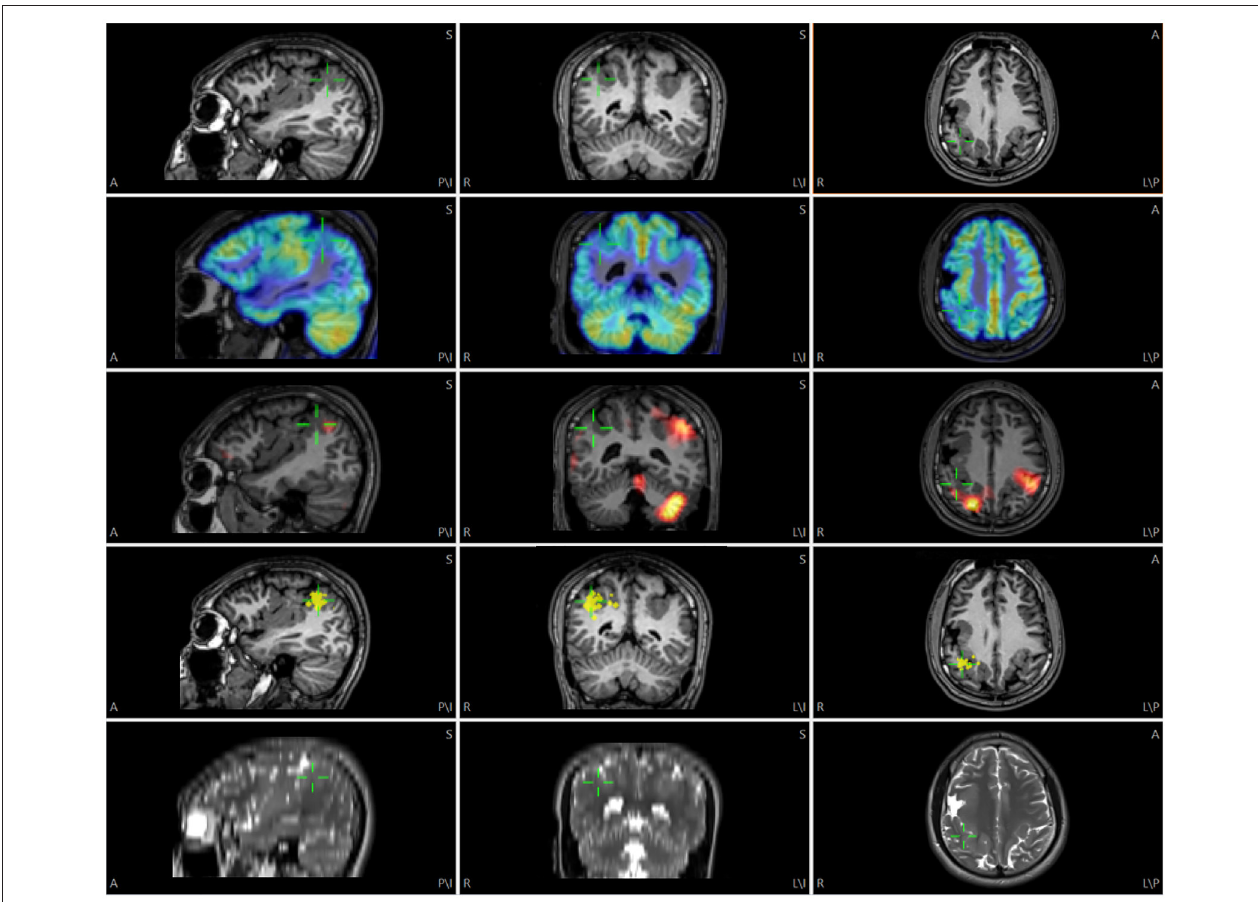
FIGURE 1 | Illustration of multimodality image integration (MMII) from a patient with bilateral polymicrogyria (PMG) undergoing non-invasive presurgical evaluation. Rows from top to down: 3D T1-weighted MRI, FDG-PET, SPECT SISCOM (z score = 1.5), MEG (dipole locations) and 2D axial T2-weighted TSE images. The green cursor is centered on the posterior part of the right-sided PMG that showed a tight MEG cluster, and the corresponding location is shown on all the other modalities by green cursors. For this and the following Figures, A, anterior; P, posterior; S, superior; I, inferior; L, left; R, right.